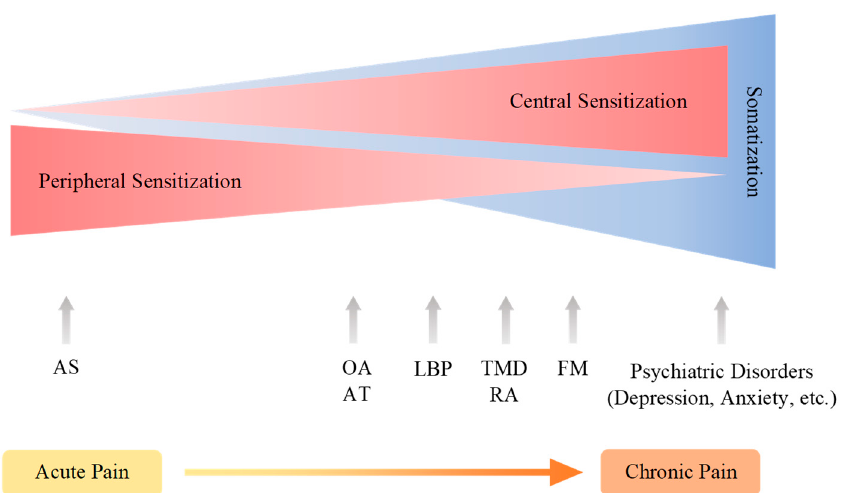
Figure 5. The continuum of pain sensitization and somatization. Chronic pain arises through a complex pathogenic process involving more components and developing into the pain continuum. Central sensitization, peripheral sensitization, and somatization are pathogenic processes of pain development spanning components of the pain pathway and the pain mechanism, which is hardly understood without the presence of the cortical perception. Acute pain may develop into chronic pain. AS: ankle sprain, OA: osteoarthritis, AT; Achilles tendinopathy; LBT: low back pain, TMD: temporomandibular joint disorder, FM: fibromyalgia.